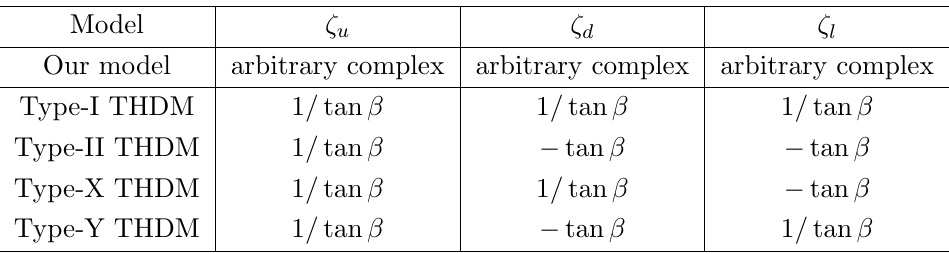
Table 1 . (cid:16) f factors in the THDMs. The names of the models are referred to refs. [65, 74]. where Q u = ( u ; V d ) T and Q d = ( V y u ; d ) T with V being the Cabibbo- L CKM L L L CKM L L CKM Kobayashi-Maskawa (CKM) matrix. In the above expression, M are the diagonalized-mass f matrices for the fermions and (cid:26) are the general complex 3 (cid:2) 3 matrices. The o(cid:11)-diagonal f elements of (cid:26) generally induce FCNCs which are strongly constrained by (cid:13)avor experi- f